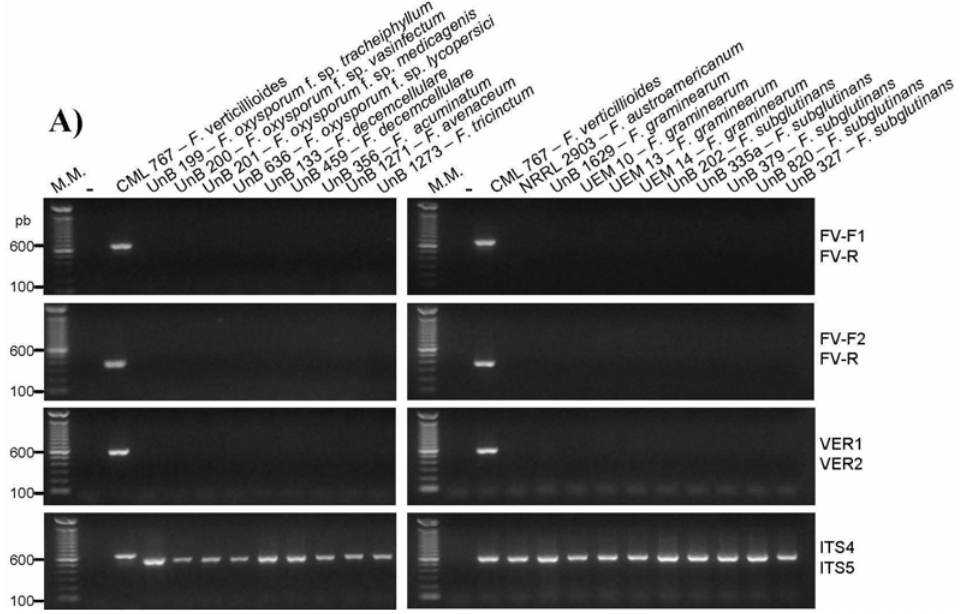
* MP = G. Fukikuroi complex Mating Population. nt = non tested . Figure 3. Specificity analysis with the isolates of Fusarium spp. genomic DNA. ( A ) FV (this work) and VER1/VER2 [14] primer pairs. ( B ) FS (this work) and SUB1/SUB2 [14] primer pairs. The PCR reactions were analyzed in 1.5% agarose gels stained with ethidium bromide. M.M. indicates the 100-bp molecular marker from Invitrogen (USA). ( − ) indicates the negative control